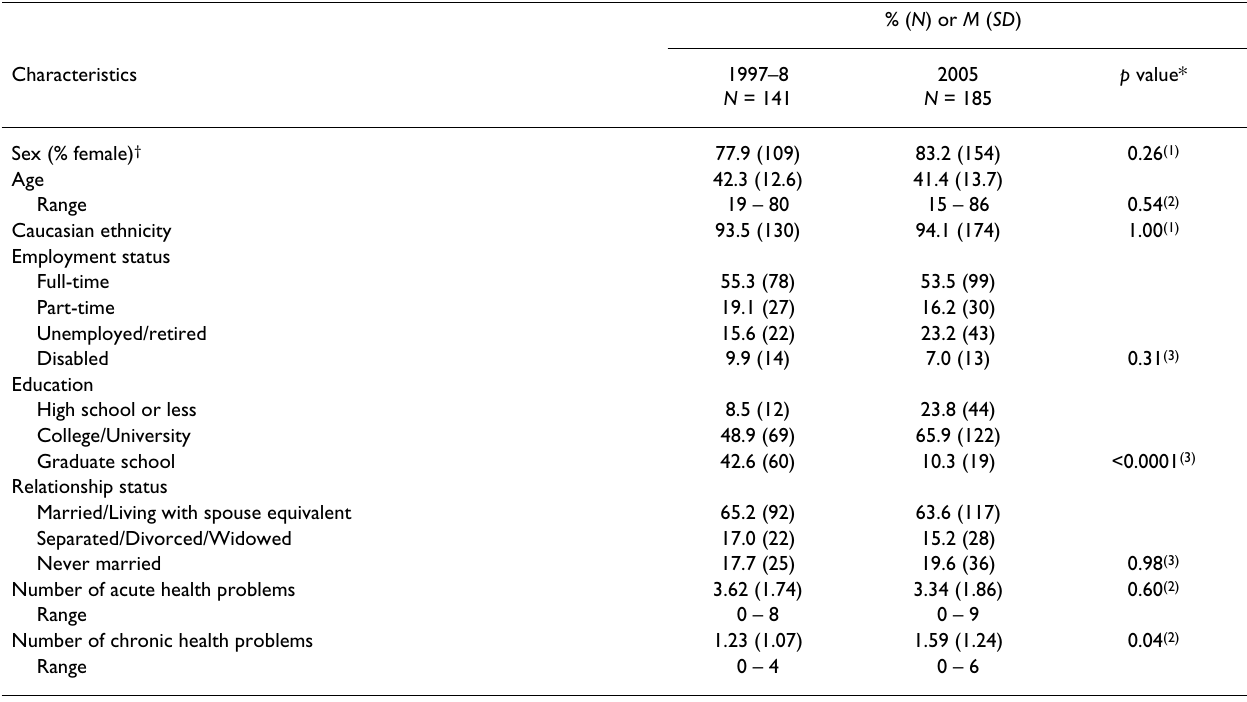
Table 1: Demographic and health characteristics of the 1997–8 and 2005 CAM consumers.